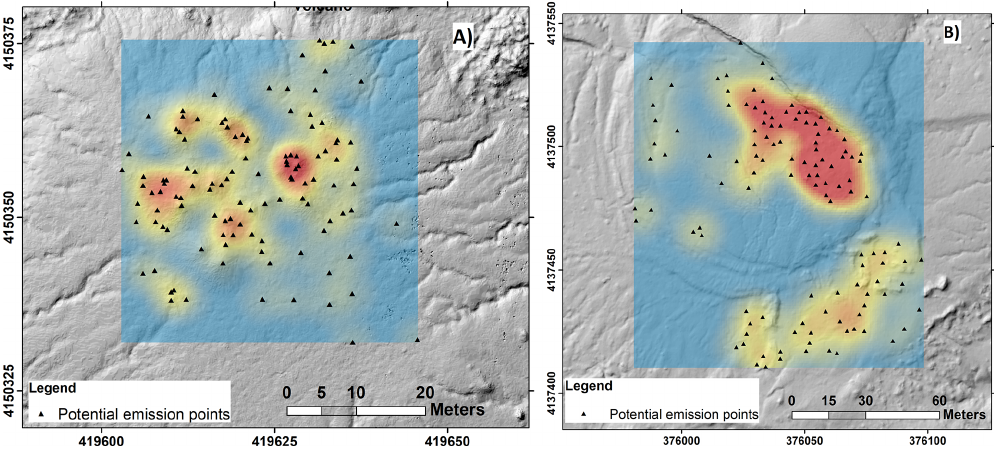
Figure 5. Density maps of the potential emission points investigated. Red: high-density values; yellow: low-density values. (A) Santa Bar- bara MV area and at (B) maccalube of Aragona (source: 2017 DSMs in ArcGIS